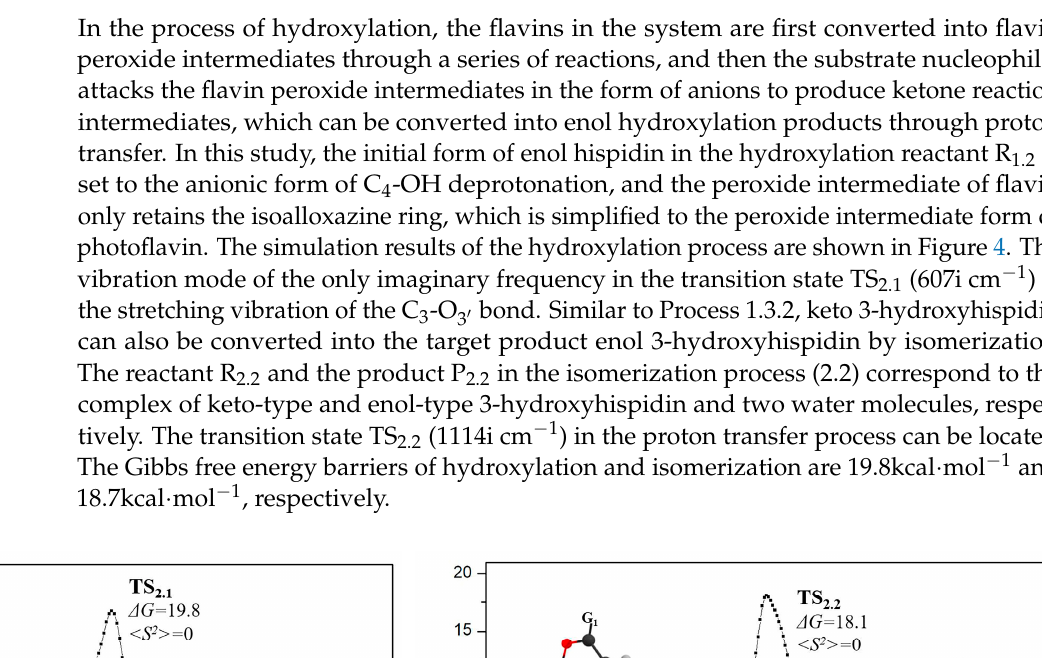
Figure 5. Under the calculated level of CAM-B3LYP/6 − 31+G**, the energy diagram of Stage 1. 3.2. Stage 3: Recovery of Utilization of Oxidation Luciferin—From Oxidized Luciferin to Caffeic Acid As Scheme 1 shows, Stage 2 follows Stage 1 studied above. In Stage 2, under the cat- alytic oxidation of luciferase, 3-hydroxyhispidin produces oxidized luciferin, namely, caffeoyl pyruvic acid, and emits green light with a wavelength of 530 nm. Stage 2 has been carefully studied [3]. Now, we consider Stage 3 in Scheme 1. In Stage 3, caffeoyl pyruvic acid is hydrolyzed into caffeic acid and pyruvic acid under the catalysis of the CPH en- zyme. CPH belongs to the fumarylacetoacetate hydrolase (FAH) superfamily [26,27]. These types of enzymes contain highly conserved FAH catalytic domains. Picher et al. reported that the FAHD1 protein, which is a kind of FAH enzyme, can catalyze the hy- drolysis of acyl pyruvic acid, and the products correspond to carboxylic acid and pyruvic